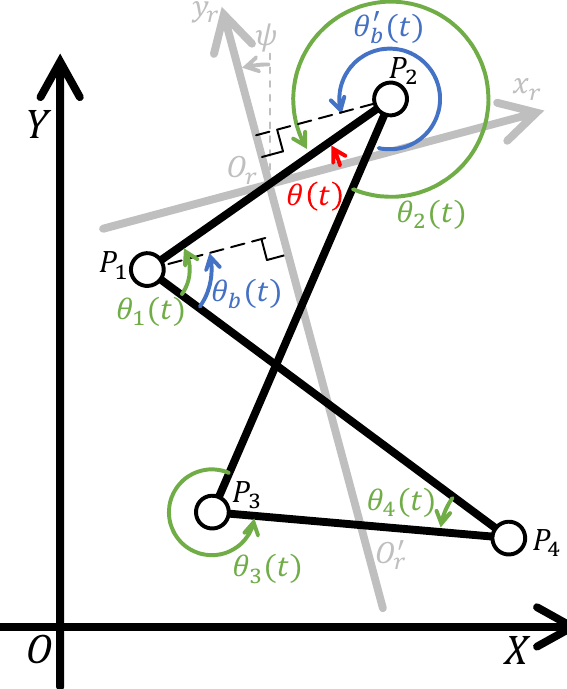
Figure 3. A schematic figure of the proposed lizard-inspired